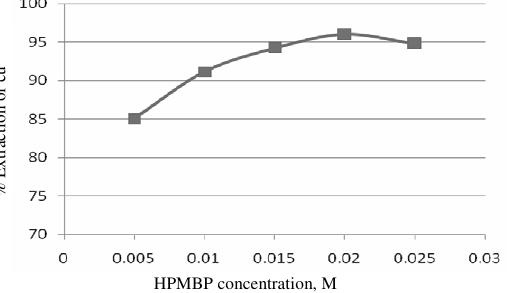
Figure 2. Effect of HPMBP concentration to extraction percentage of